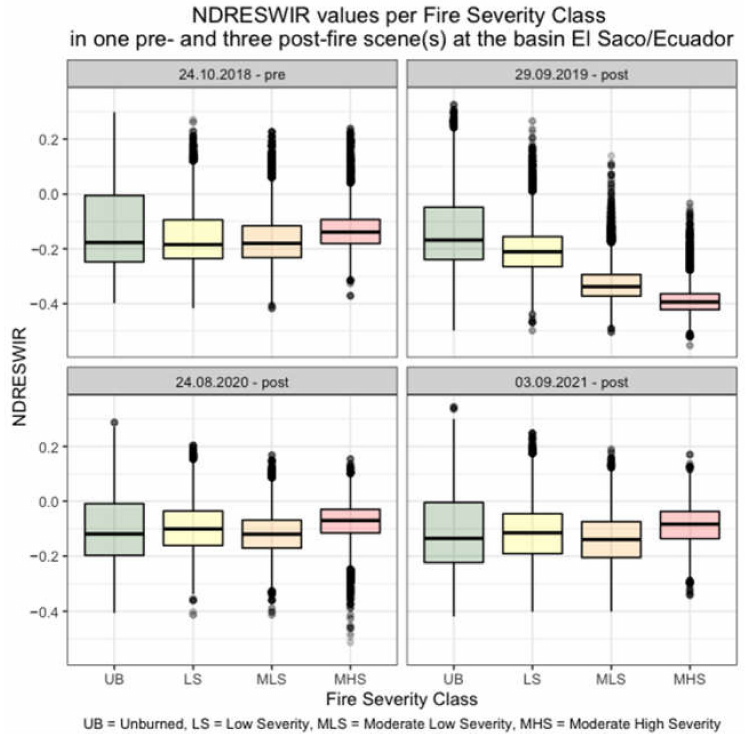
Figure 6. Boxplots of NDRESWIR values in the fire severity classes at the El Saco basin in one pre- and three post-fire Sentinel 2